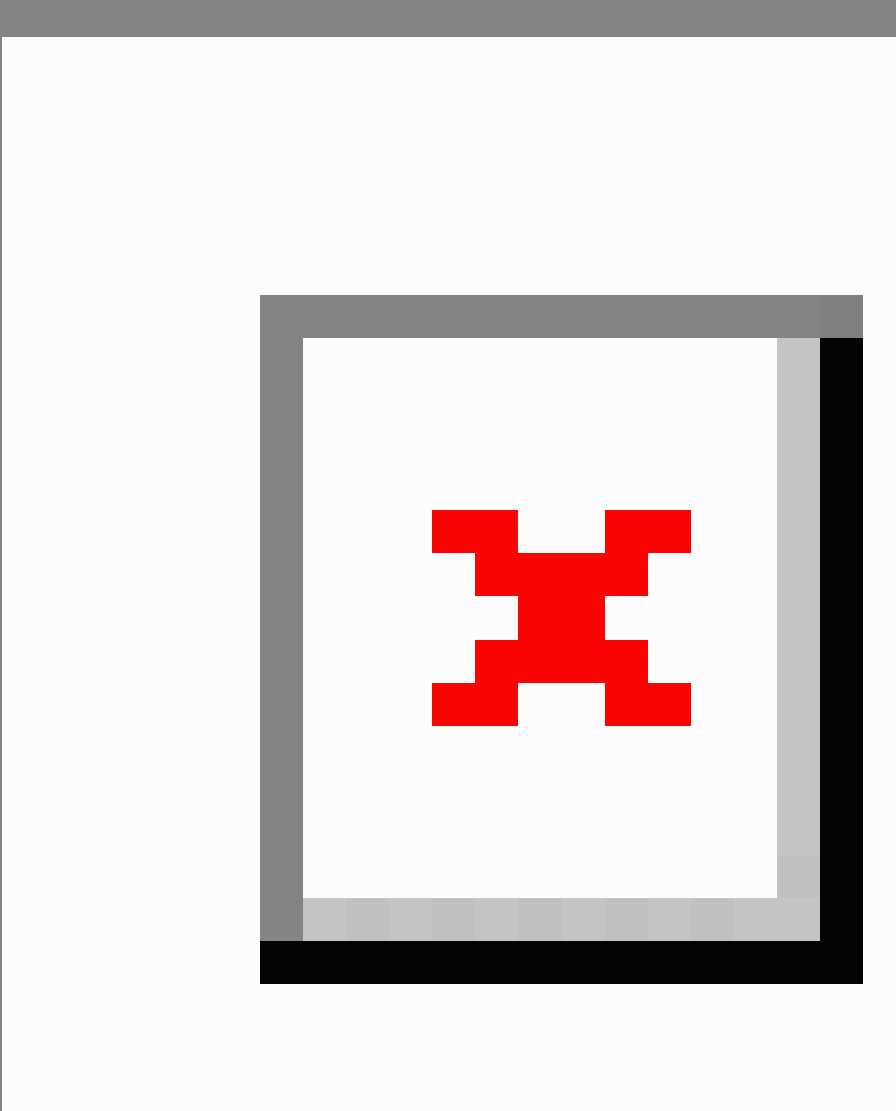
Figure 4. Participant progress display pre- and post-pilot versions.